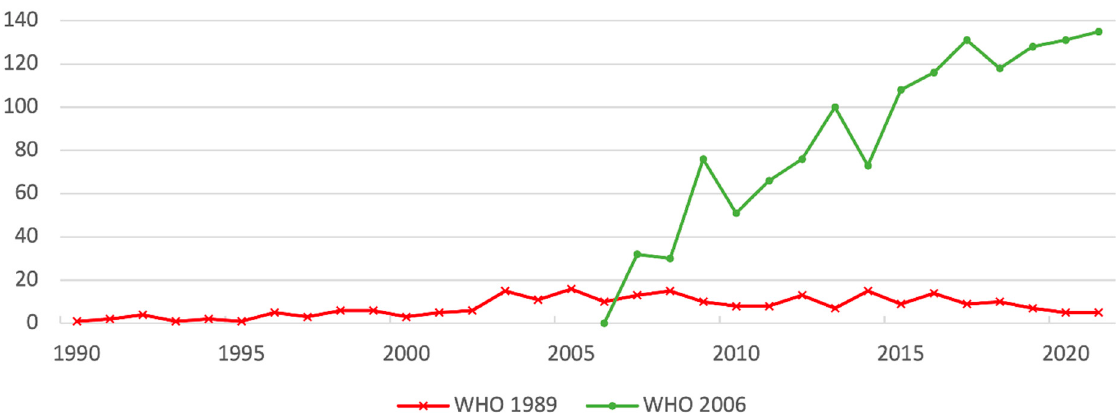
Figure 1. Number of WHO wastewater use guideline citations in academic journals (based on extractions from Scopus on 13 January 2022). While Figure 1 implies an increasing interest in the 2006 guidelines, many of the papers referencing the 2006 edition use only the 1989 water quality thresholds in their texts.